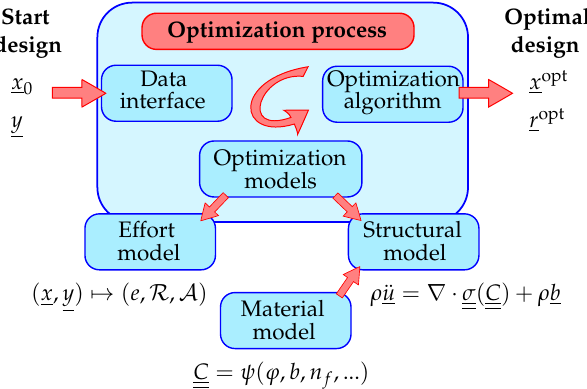
Figure 12. General optimization process as by